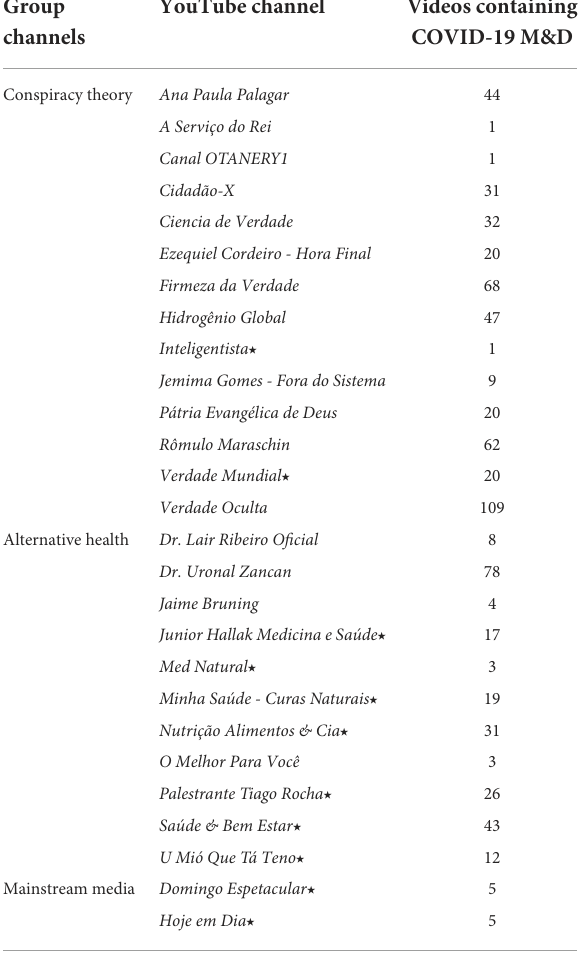
TABLE 2 Channels spreading COVID-19